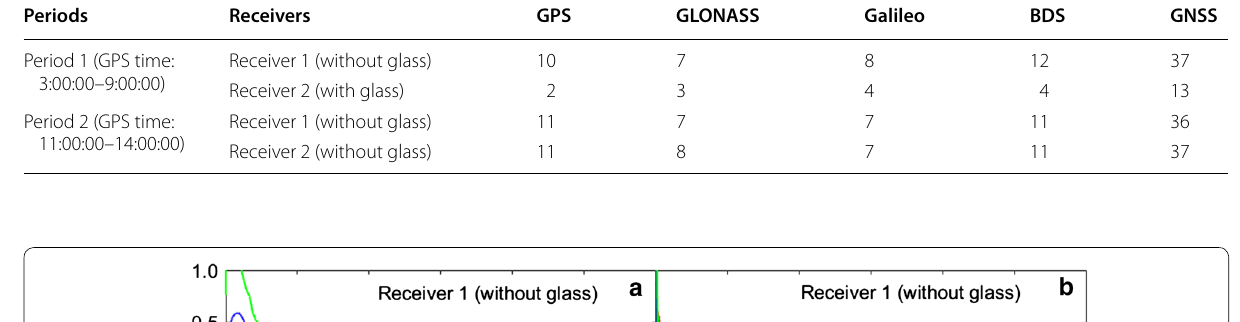
Table 6 Average number of visible satellites of two receivers during two test periods Periods Receivers